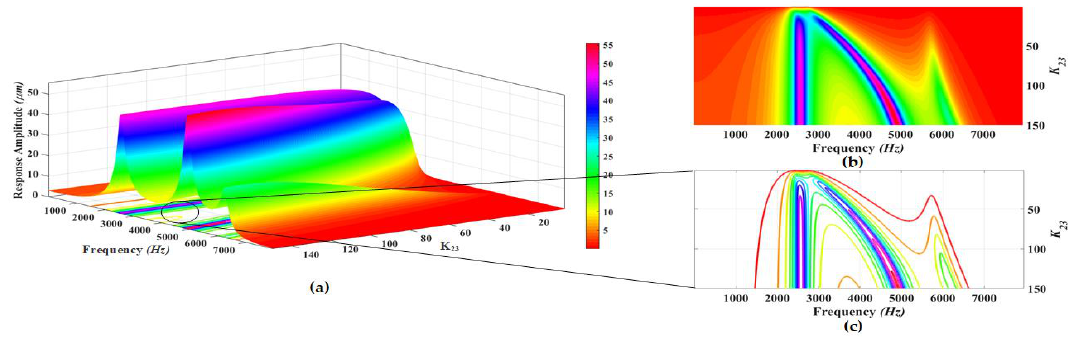
Figure 10. ( a ) Response amplitude and bandwidth optimization graph for the variation of 𝑘 23 ; ( b ) Top view and ( c ) Contour plots of the system response.